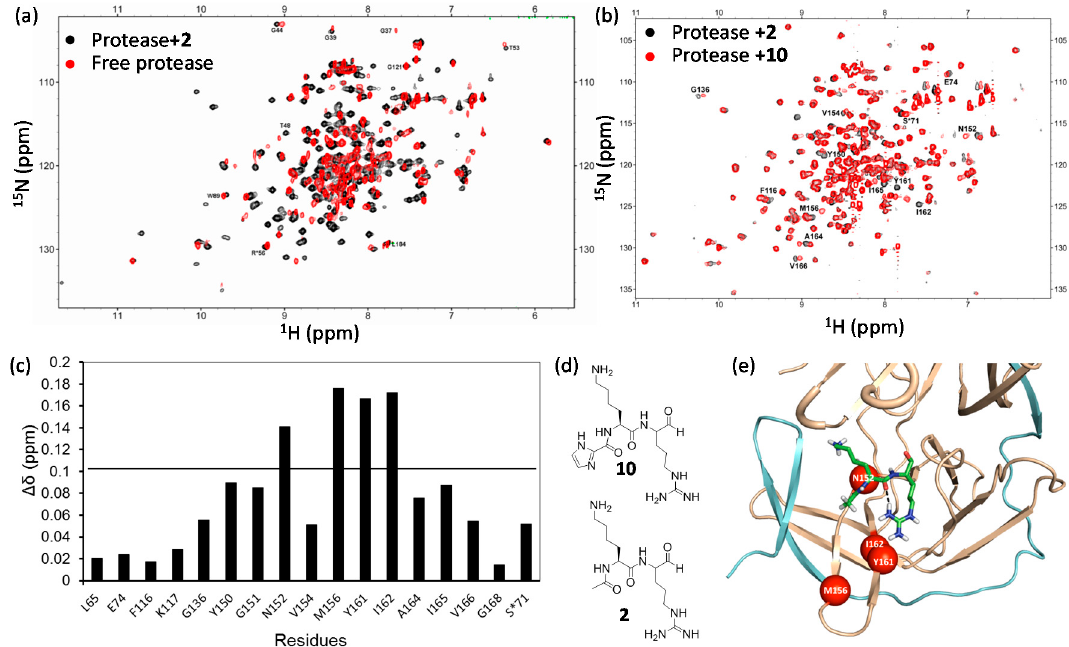
Figure 4. West Nile virus protease and inhibitor interactions. ( a ) Superimposed 1 H- 15 N-HSQC spectra of protease in the absence (red) and presence (black) of compound 2 ; ( b ) Superimposed 1 H- 15 N-HSQC spectra of protease in the presence of compound 2 (black) and compound 10 (red); ( c ) Chemical shift difference of protease in the presence of 2 and 10 ; ( d ) Structures of compound 2 and compound 10 ; ( e ) Structural model of West Nile virus protease in complex with 2 . The inhibitor is shown in sticks. The residues exhibit obvious different chemical shifts are shown in red spheres. NS2B and NS3 poly-peptides are shown in cyan and orange, respectively. This figure is obtained from the reference [136] with slight modifications.